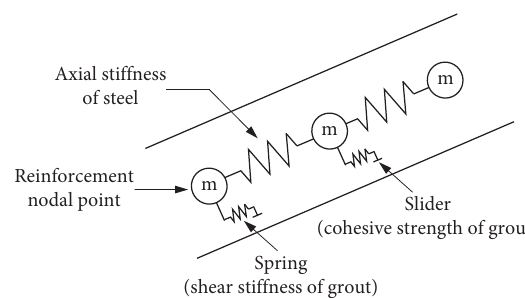
Figure 6: Mechanical representation of fully bonded